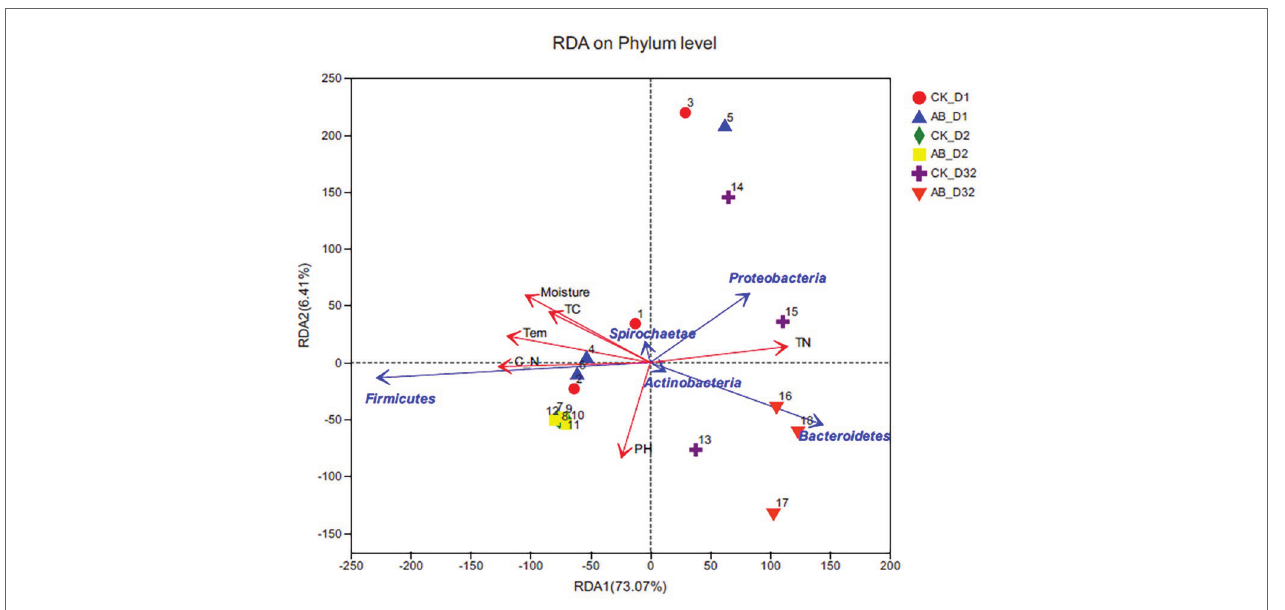
FIGURE 7 | Redundancy analysis between environmental factors and microbial community structure (phylum level). CK: the swine manure composting. AB: add 1% compound microbial agents in the swine manure composting. D1 represents the mesophilic phase, D2 represents the thermophilic phase, and D32 represents the maturation phase.